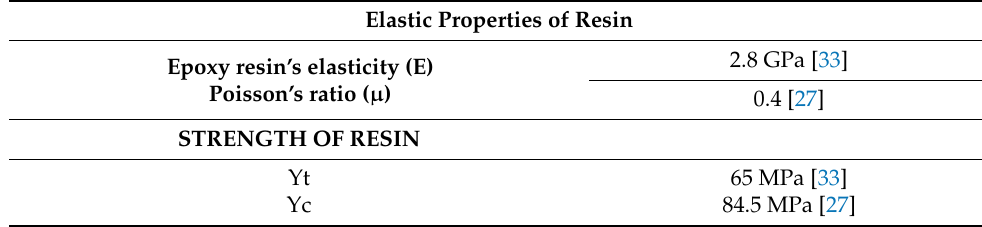
Table 3. Epoxy resins elastic